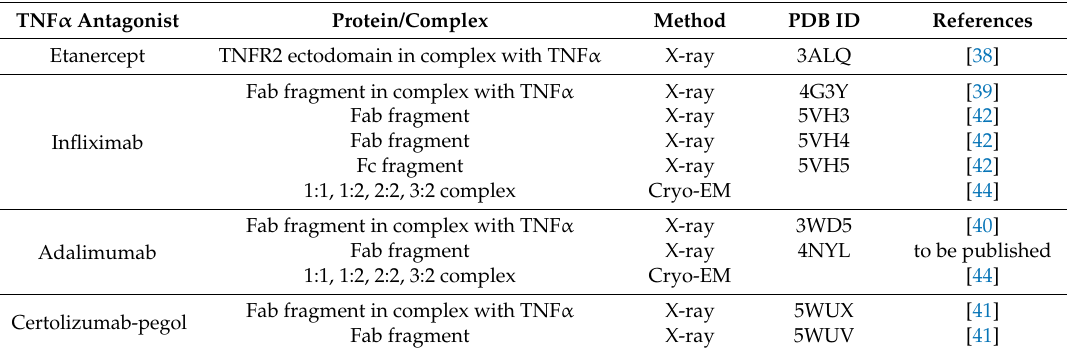
Table 2. List of the TNF α antagonists related